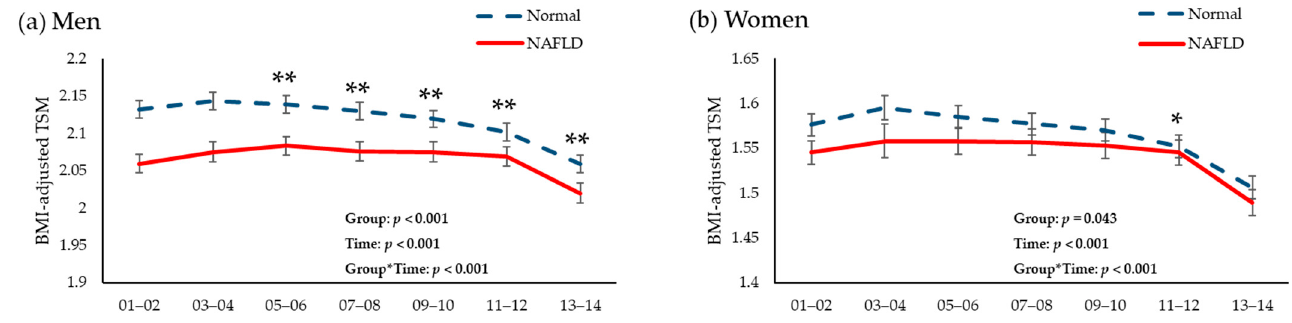
Figure 4. Changes in total skeletal muscle mass/body mass index during the 12-year follow-up period according to the presence of non-alcoholic fatty liver disease in ( a ) men and ( b ) women. Abbreviations: NALFD, non-alcoholic fatty liver disease; BMI, body mass index; TSM, total skeletal muscle mass index; CVD, cardiovascular disease. p was calculated after adjusting for age, sex, abdominal obesity, physical activity, smoking status, current drinking status, basal energy expendi- ture, daily protein intake, mean blood pressure, fasting glucose, total cholesterol, and history of CVD. * p < 0.05. ** p < 0.001.